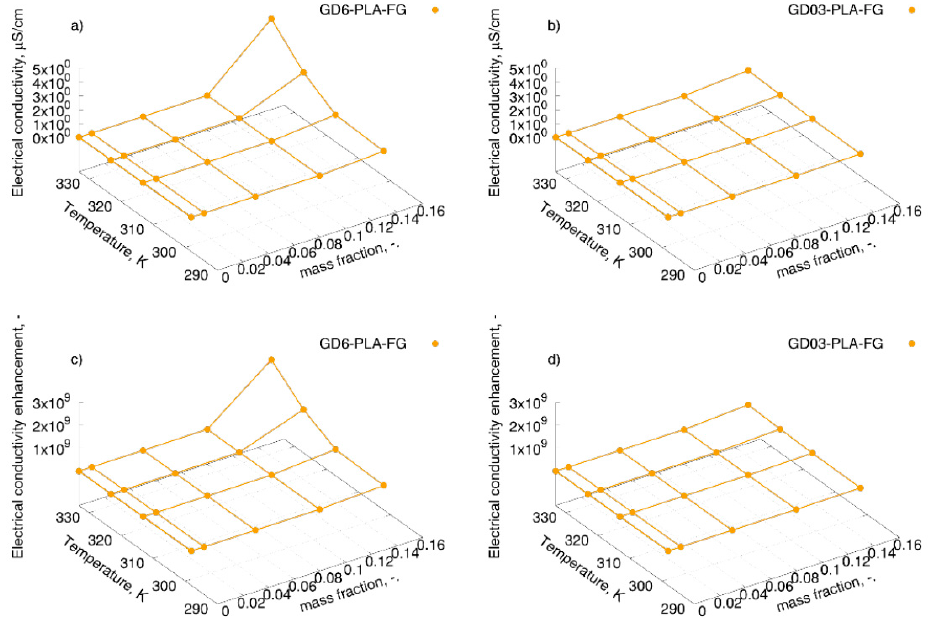
Figure 7. Electrical conductivity of: ( a ) GD6-PLA-FG, and ( b ) GD03-PLA-FG nanocomposites, and electrical conductivity enhancement designated as the ratio of conductivity at 0.1 Hz of the specimen to the conductivity of uuPLA in each temperature for ( c ) GD6-PLA-FG, and ( d ) D03- PLA-FG. Table 1. Electrical conductivities and their enhancements designated as the ratio of conductivity at 0.1 Hz of the specimen to the conductivity of uuPLA in each temperature for two types of the graphite/diamond mixtures PLA nanocomposites. Sample